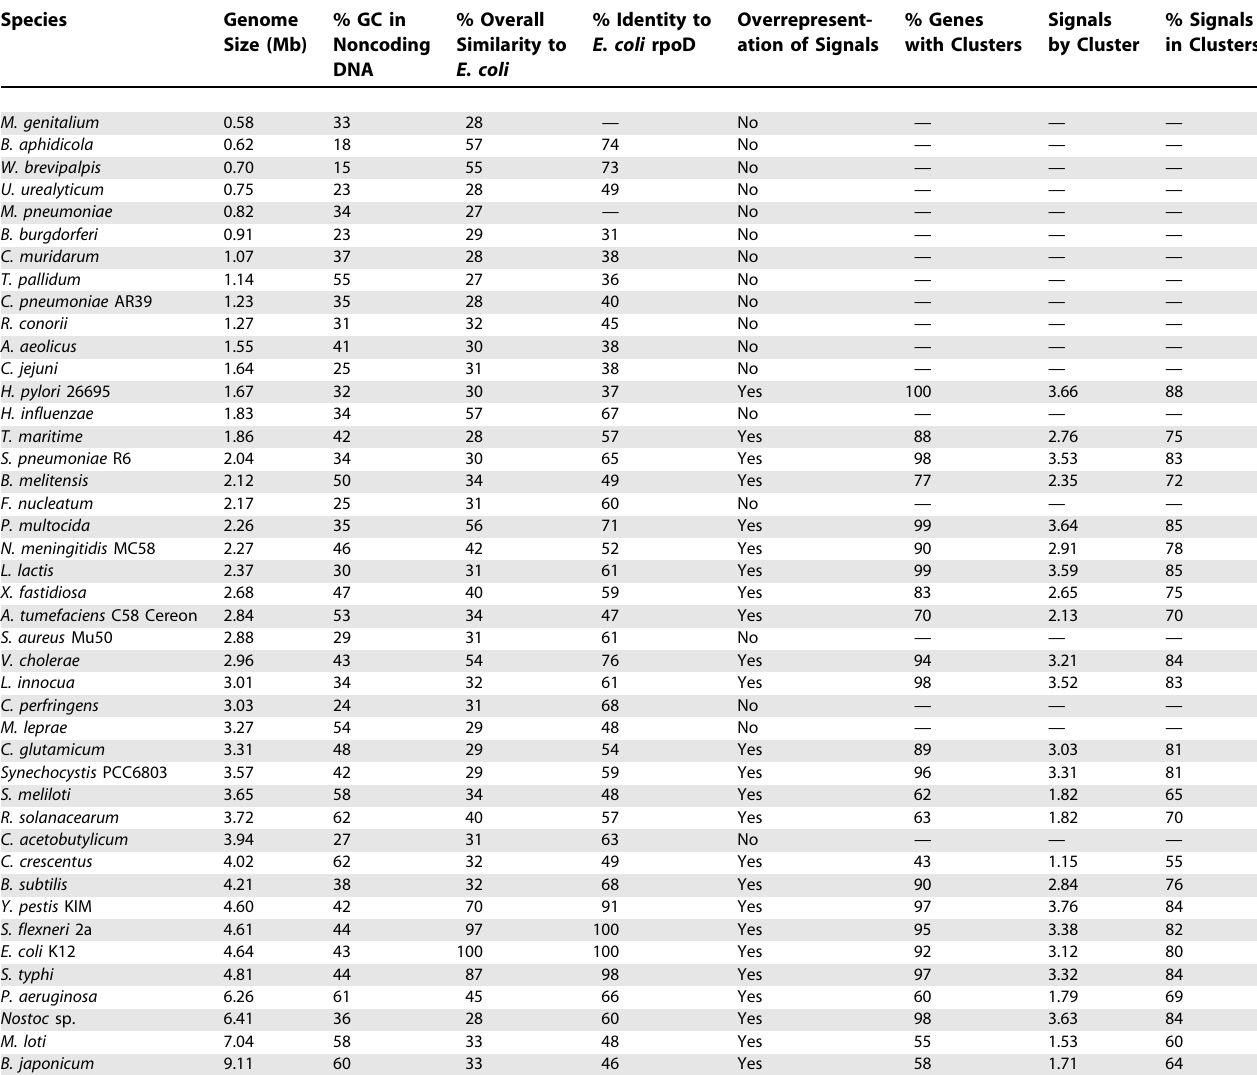
Table 2. Density Patterns of r 70 Promoter-Like Signals in Eubacterial Genomes Species Genome